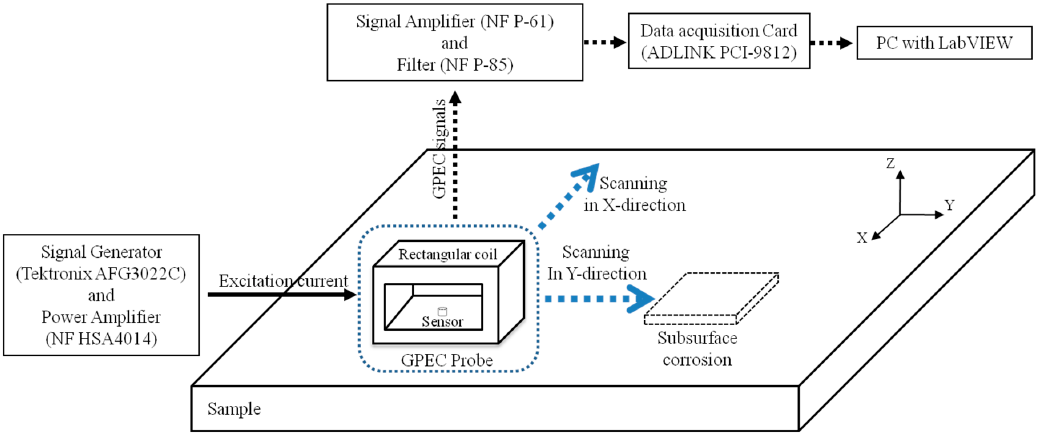
Figure 7. Schematic illustration of the corrosion imaging system with the proposed GPEC probe and sample. Table 3. Profiles and sizes of subsurface corrosion.